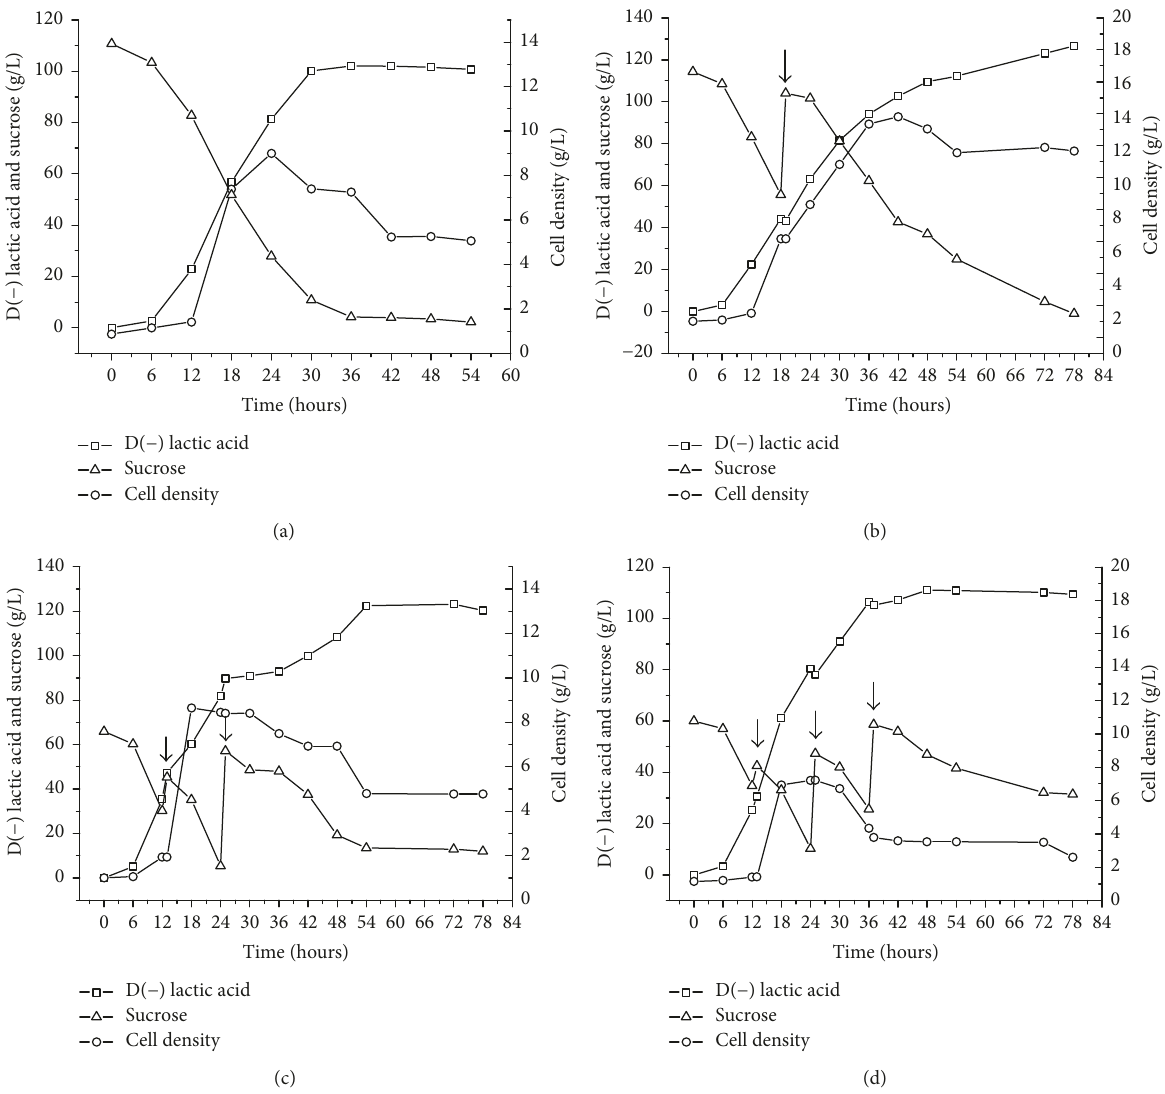
Figure 5: Time courses of sucrose consumption, D( − ) lactic acid production, and cell growth in batch fermentation (a), pulse fed-batch (b), and multipulse fed-batch fermentation (c and d) by S. nakayamae . Experimental conditions: medium containing 35 g/L of yeast extract and 7.5 mL/L of GYP salts and crystallized sugar (as required); pH 6.0, NaOH 10N as controlling agent, temperature at 35 ∘ C, 125 rpm, and 20% of inoculum